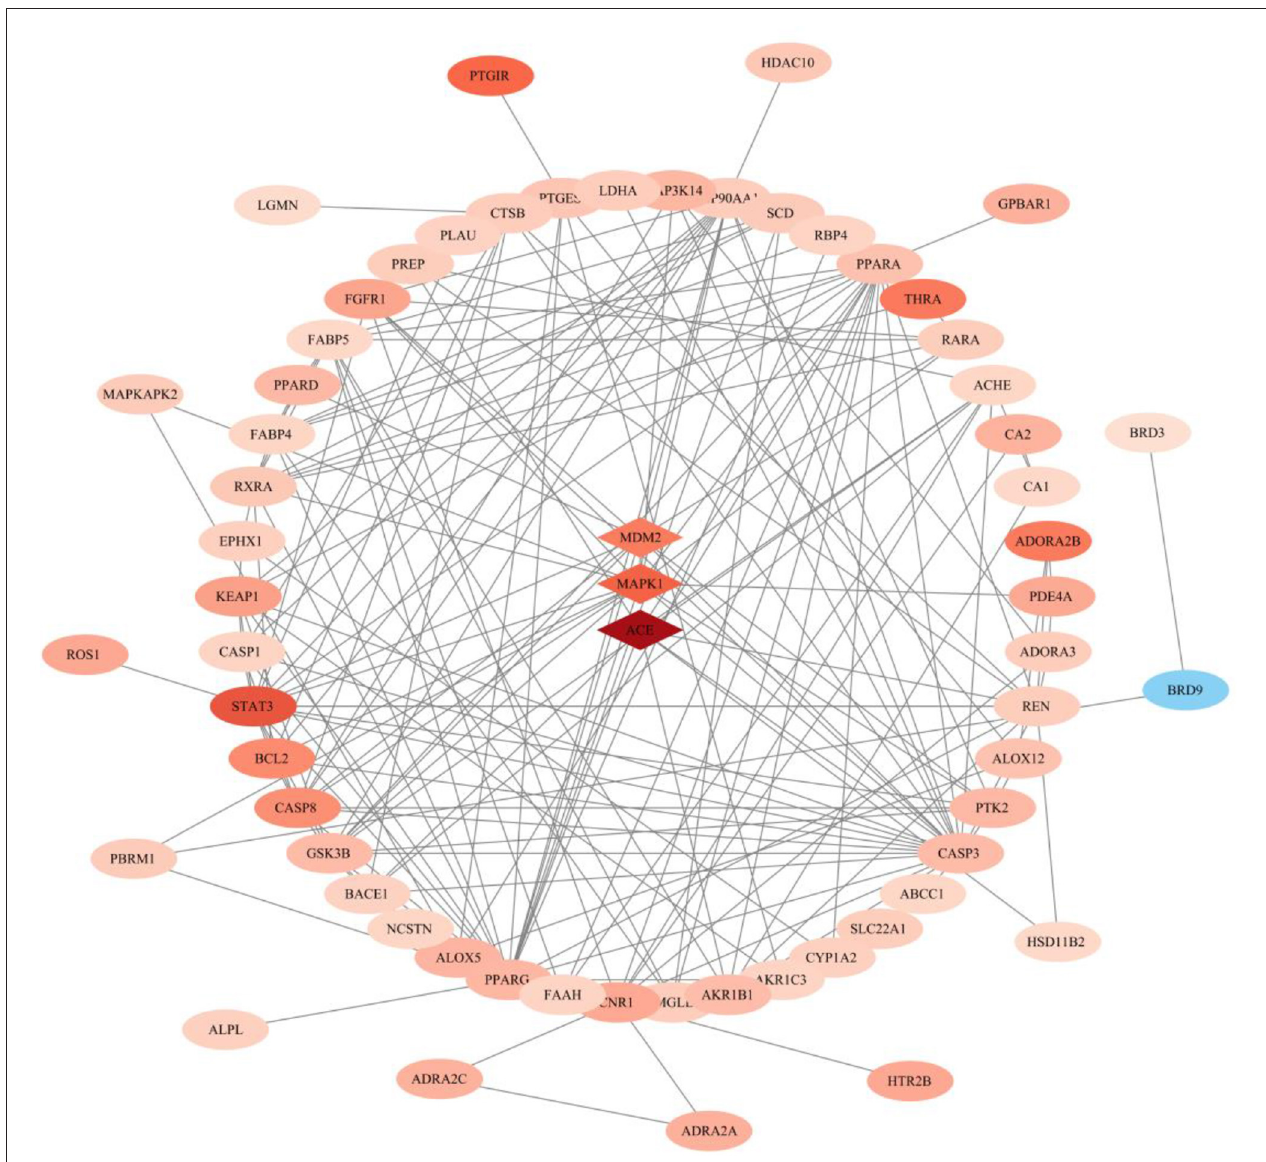
FIGURE 6 | Gene–phenotype correlation analysis of anti- heterotopic ossification targets of Palovarotene. Intersection genes were categorized as directly (the diamond in the middle) or indirectly (outer ellipse) associated with the HO phenotype. The darker the color, the larger the score value, the lighter the color, the smaller the score